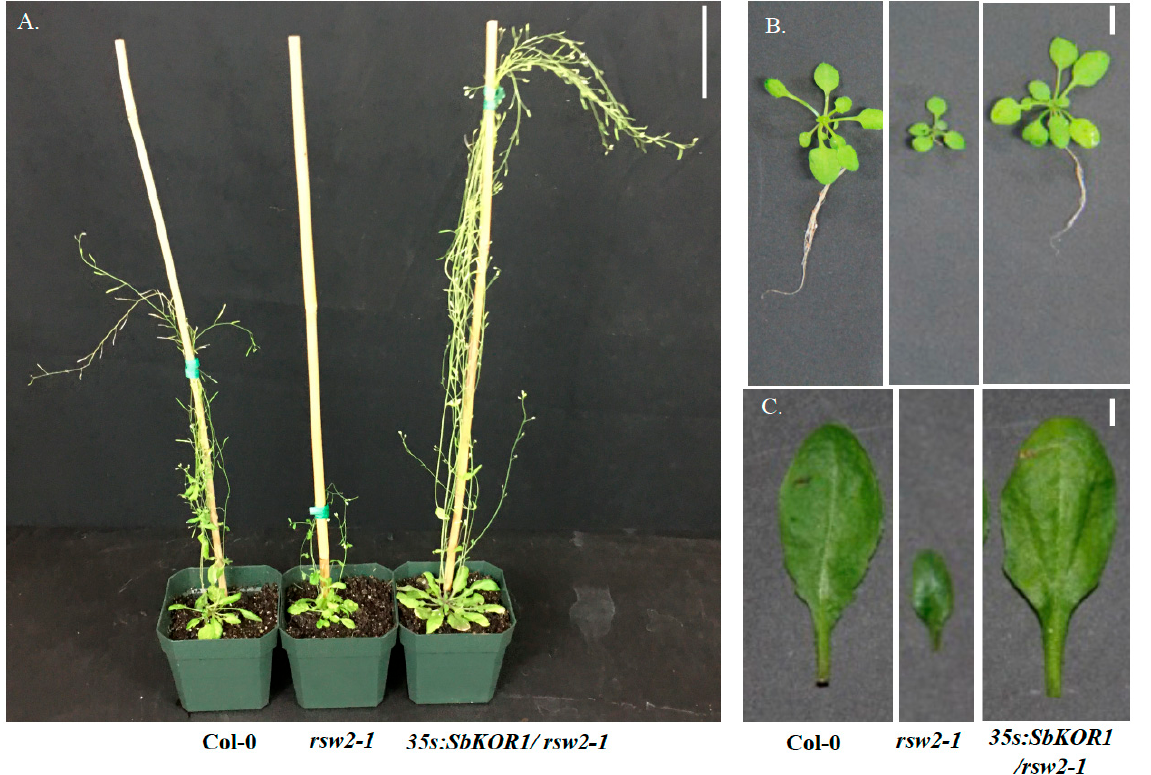
Figure 6. A. Col-0 and rsw2-1 mutant were compared with the transformed overexpression construct of sorghum, SbKOR1 in rsw 2-1 mutant of Arabidopsis ( 35s:SbKOR1/rsw2-1 ). Scale bar: 9 cm. B. Whole plants of Col-0, rsw2-1 mutant, and overexpressor ( 35s:SbKOR1/rsw2-1 ). Scale bar: 0.5 cm. C. Leaf of Col-0, rsw2-1 mutant, and Overexpressor ( 35s:SbKOR1/rsw2-1 ). Scale bar: 0.5 cm.